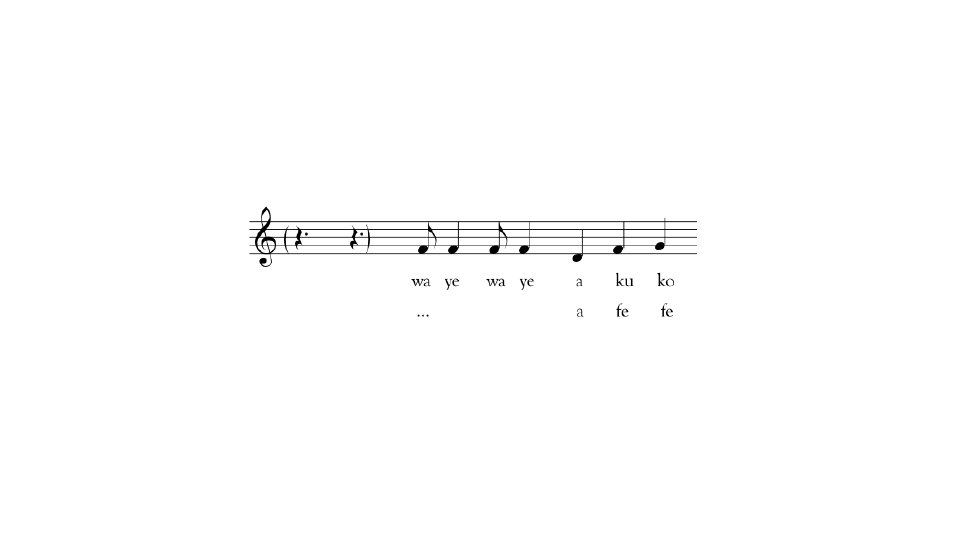
Figure 4. Sketch of a melody shared by both a novel orisha song composed by Juan García ( waye waye afefe ) and its anonymous antecedent ( waye waye akuko ). Liturgically, both songs are associated with Oya, fierce female orisha of wind and storms.